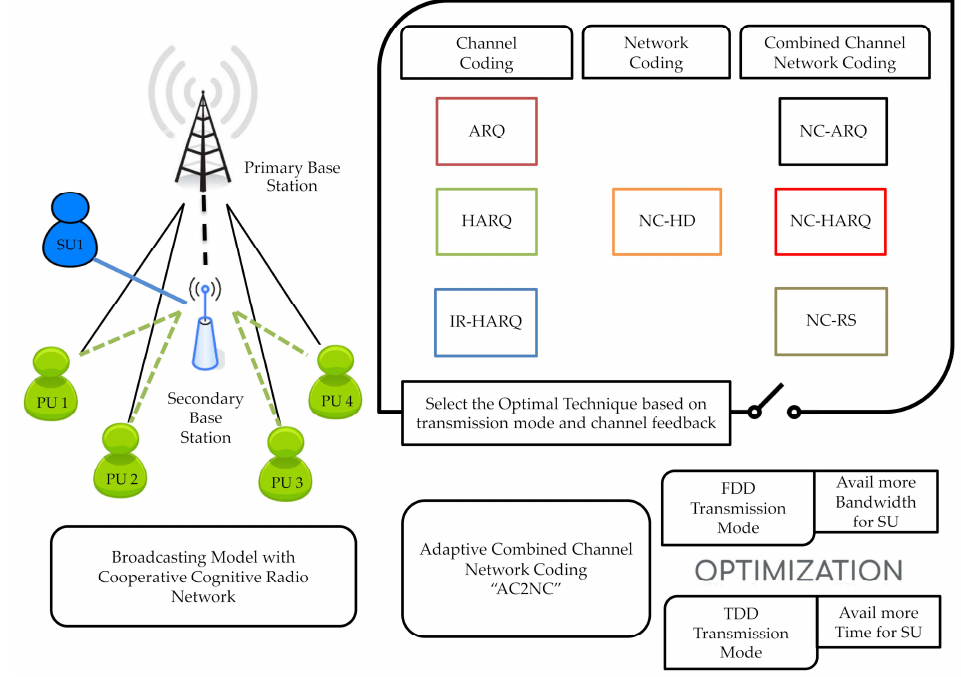
Figure 1. Broadcasting system model, single PBS, single SBS, and four primary users.